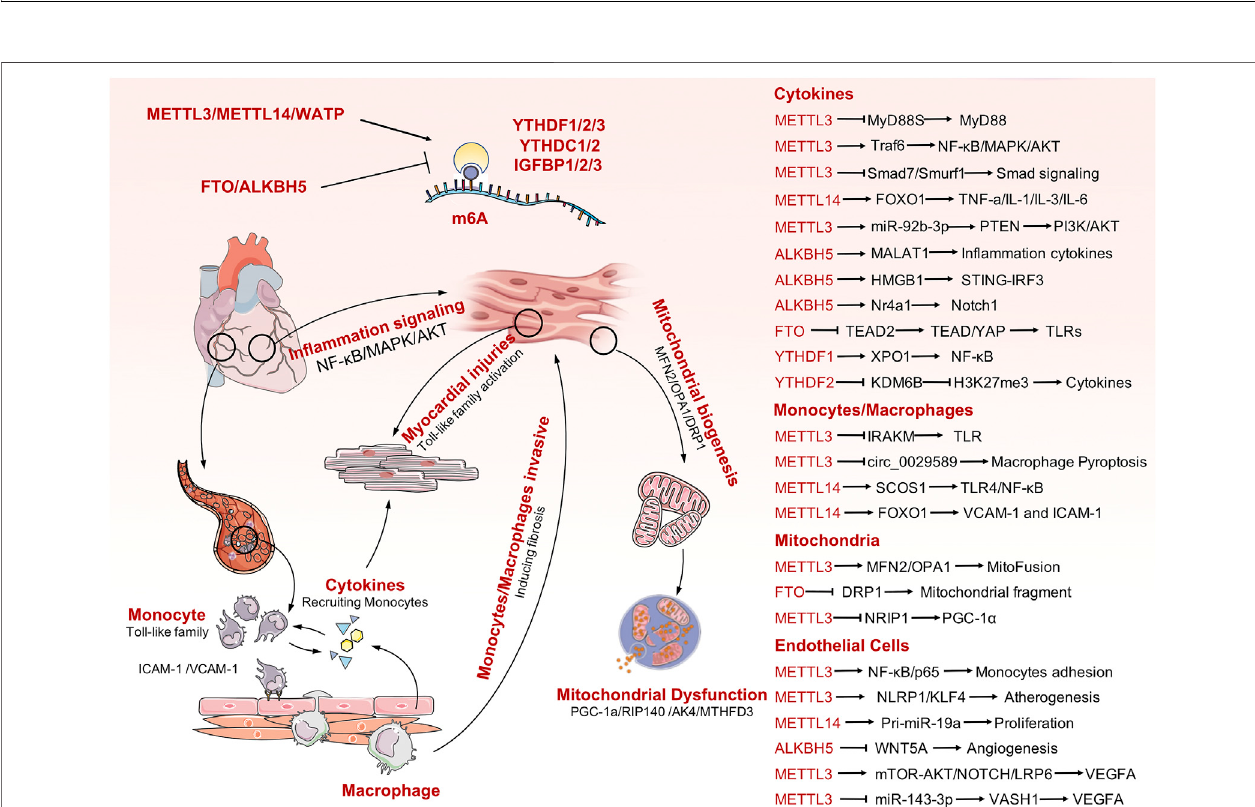
FIGURE2| ThemechanismsinvolvedinSICD andthepotentialm6Amodi fi cation process thatwouldcontribute toSICD.Someimportant m6A-mediatingtargets or signaling pathways are also listed in the right panel.